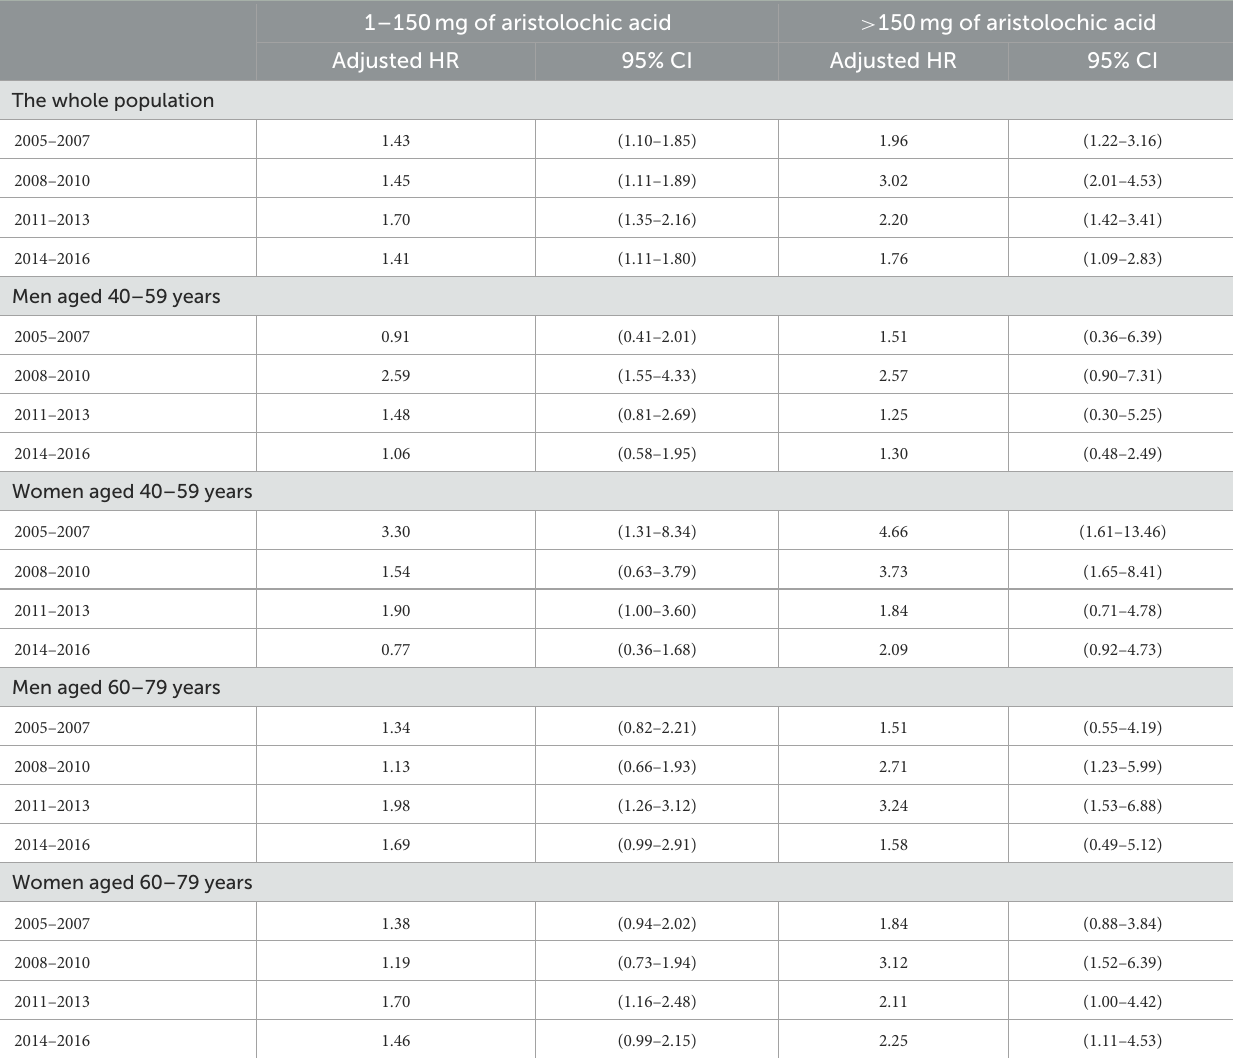
TABLE 3 Adjusted hazard ratios for the occurrence of upper tract urothelial carcinoma between 2005 and 2016, based on the piecewise constant hazard